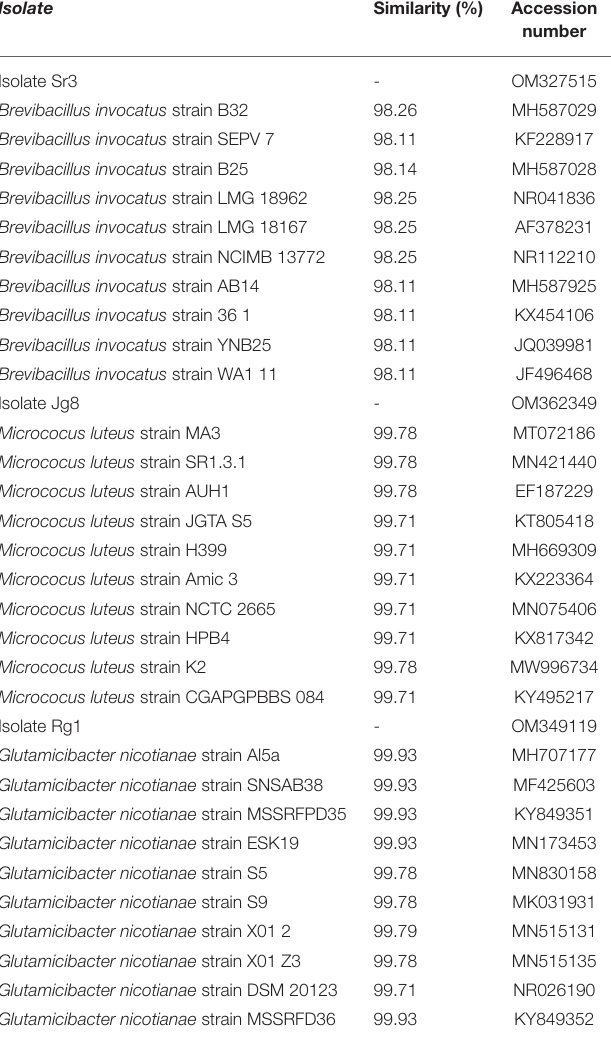
TABLE 5 | Comparison of percentage of similarities of 16S rRNA gene of isolate Rg1, Sr3, and Jg8 with several DNA sequences of GenBank using BLAST